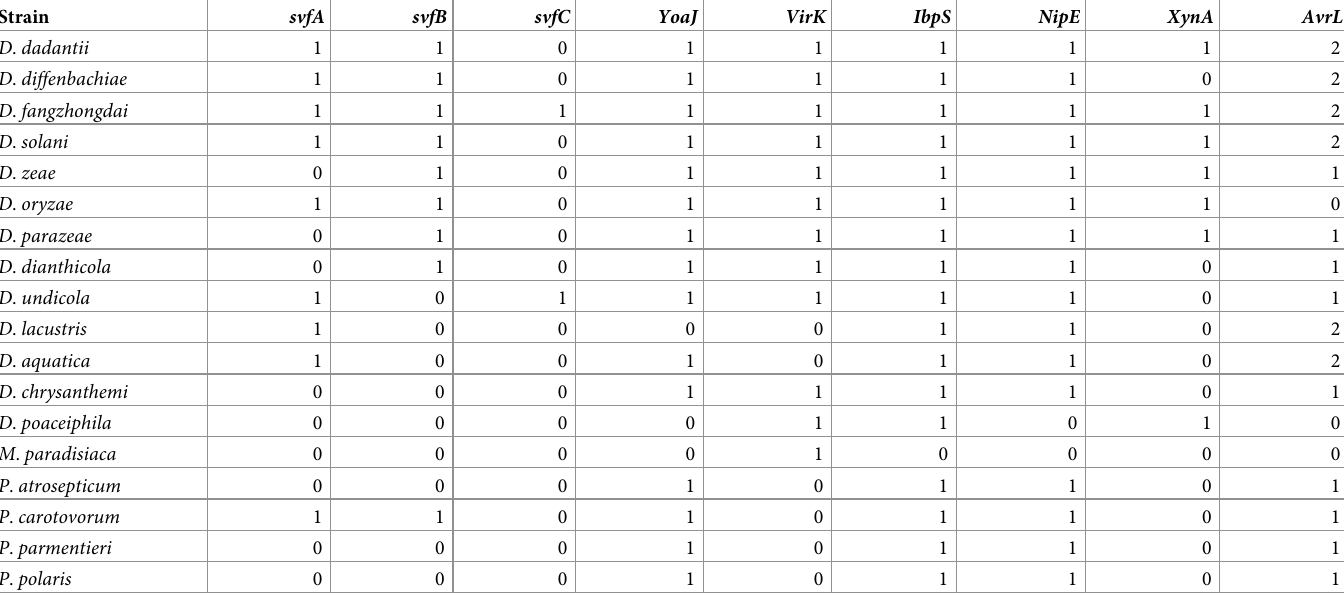
Table 1. Presence of Out-secreted proteins in various Dickeya , Musicola and Pectobacterium strains.